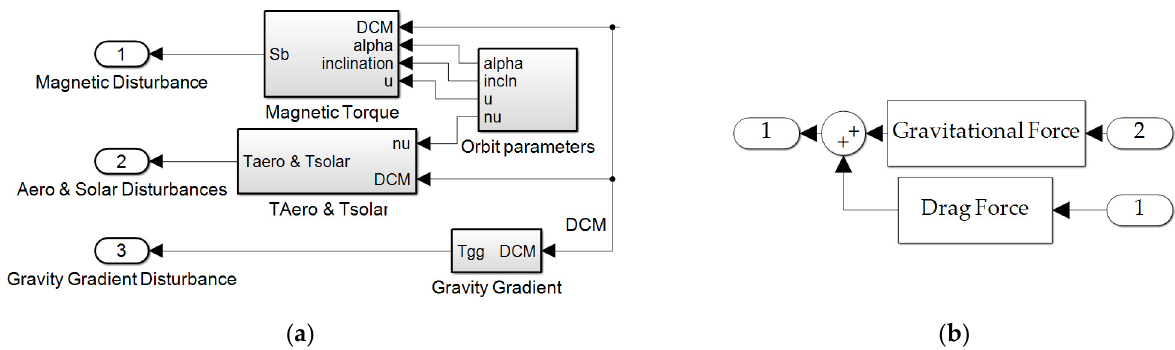
Figure A6. SIMULINK subsystems in Figure A1 ( a ) Disturbances subsystem; ( b ) Translation subsystem.